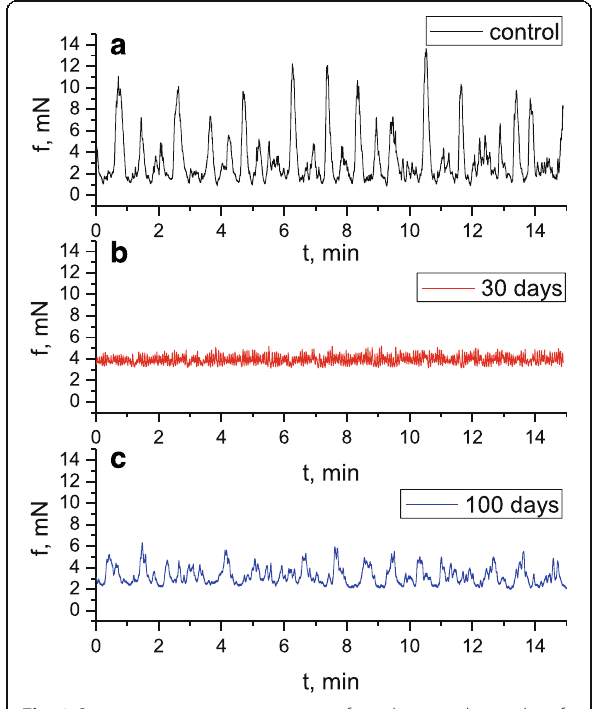
Fig. 2 Spontaneous contractive activity of circular smooth muscles of the caecum of the rats in the control group ( a ) and the group of rats, burdened with the suspension of titanium dioxide for 30 days ( b ) and 100 days ( c )